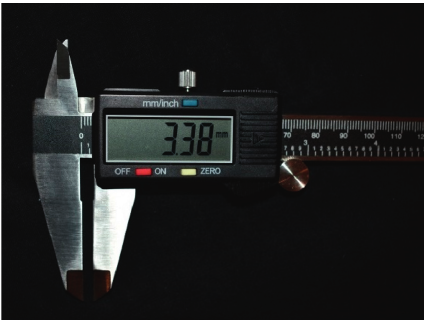
Figure 1: Fowler Electronic Digital Caliper used in this